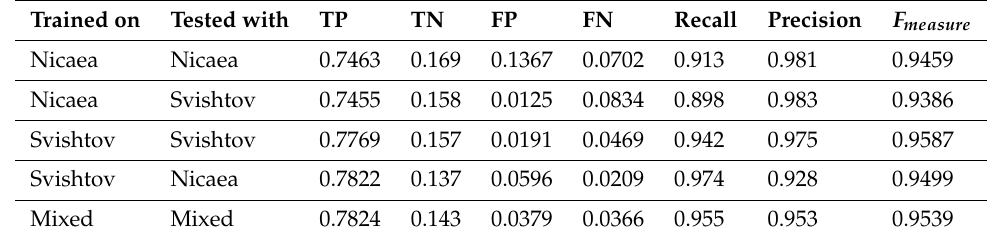
Table 3. True positive, true negative, false positive, false negative, precision, recall, and F measure results are presented for the five different models. The results were obtained for combined objects (populated place start and individual objects) versus background.